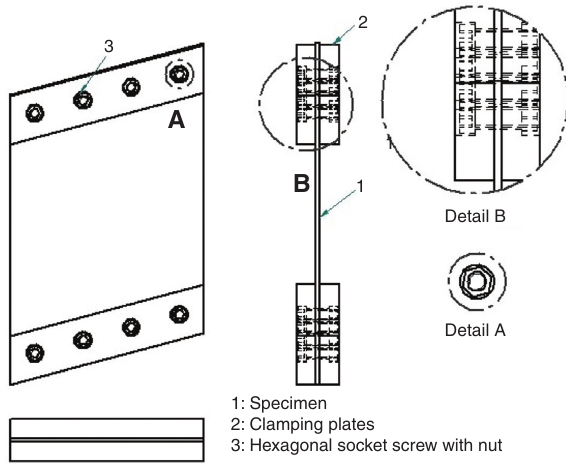
Figure 2 Fixture for holding the specimen.